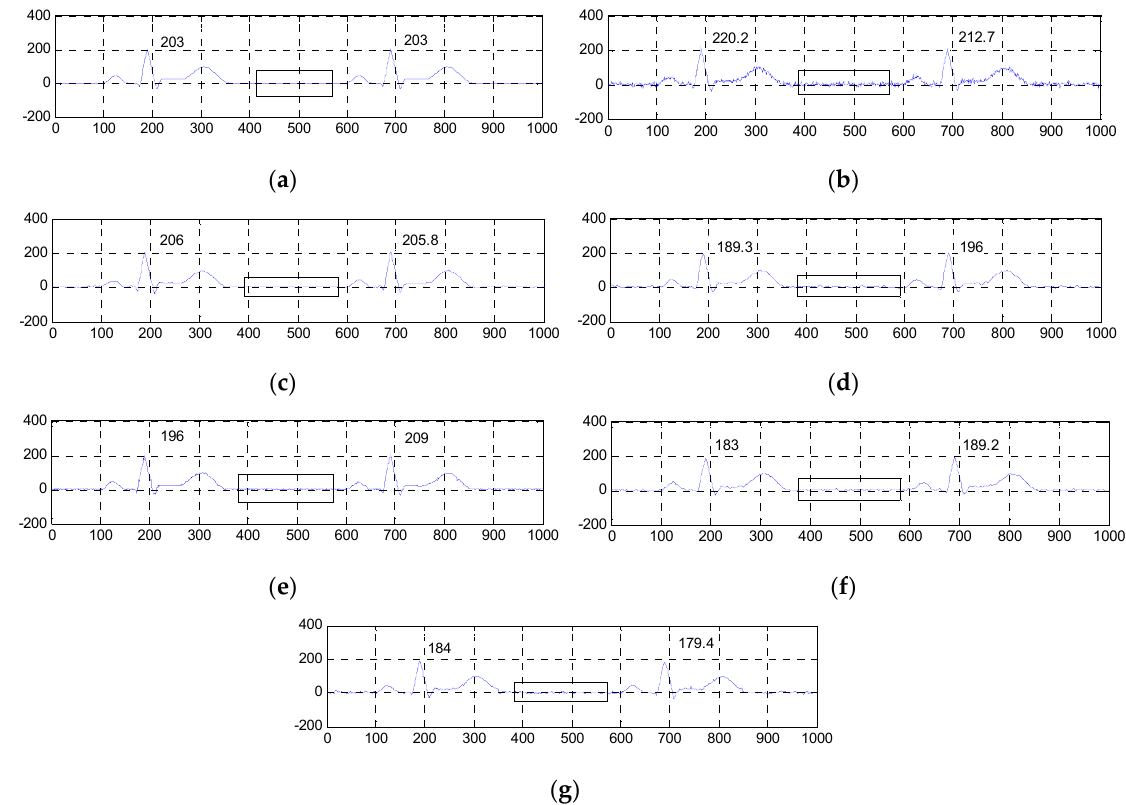
Figure 4. Comparison of denoised results of the ESMD-NLM method and other four methods operating on the simulated ECG signal. ( a ) The original ECG signal, ( b ) the noisy ECG signal (Gaussian white noise, σ 2 = 50), ( c ) the ESMD-NLM method, ( d ) the EEMD method, ( e ) the NLM method, ( f ) the VMD method, ( g ) the MED filter. The digits and the black box represent the values of amplitudes and the P-Q and S-T segments of ECG signals, respectively.